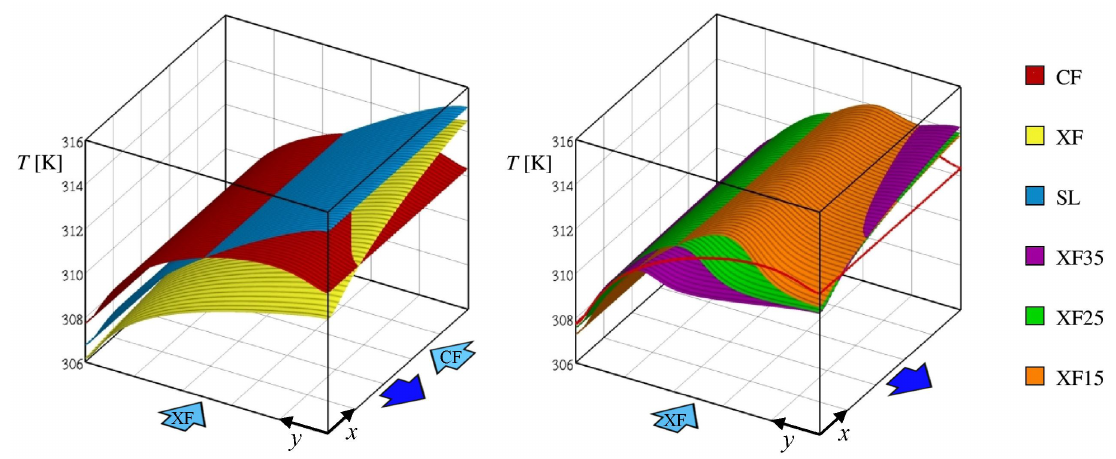
Figure 4. Bottom wall temperature distributions for six MCHS configurations and ˙ V = 5.0 mL/s (dark blue arrow: bottom layer; light blue arrow: top